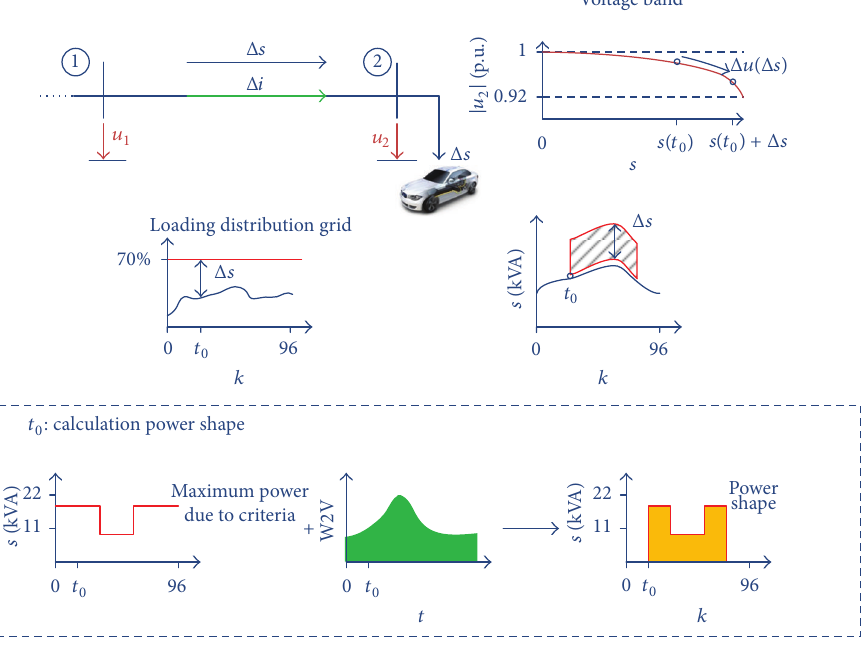
Figure 3: Calculation of the restriction function [3, 21].